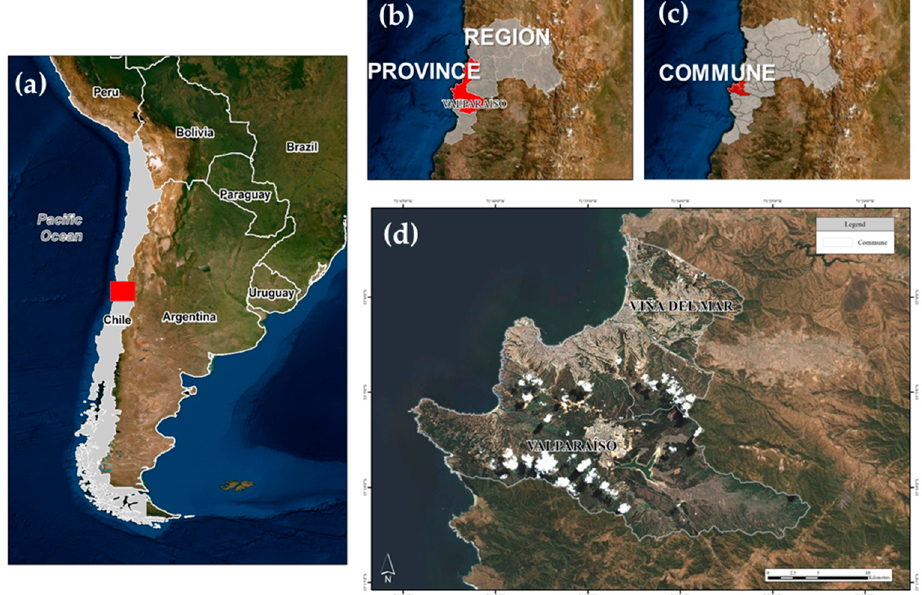
Figure 1. Location of the study area within ( a ) Chile, ( b ) the Valparaíso region (grey) and Valparaíso province (red), and ( c ) communes of Valparaíso and Viña del Mar. ( d ) Detailed image of the two communes, showing Sentinel-2 images for 21 September 2019 (downloaded from the Copernicus Open Access Hub of the European Space Agency (ESA)). Map data © Google Earth 2019. Edited from [50] and [59].